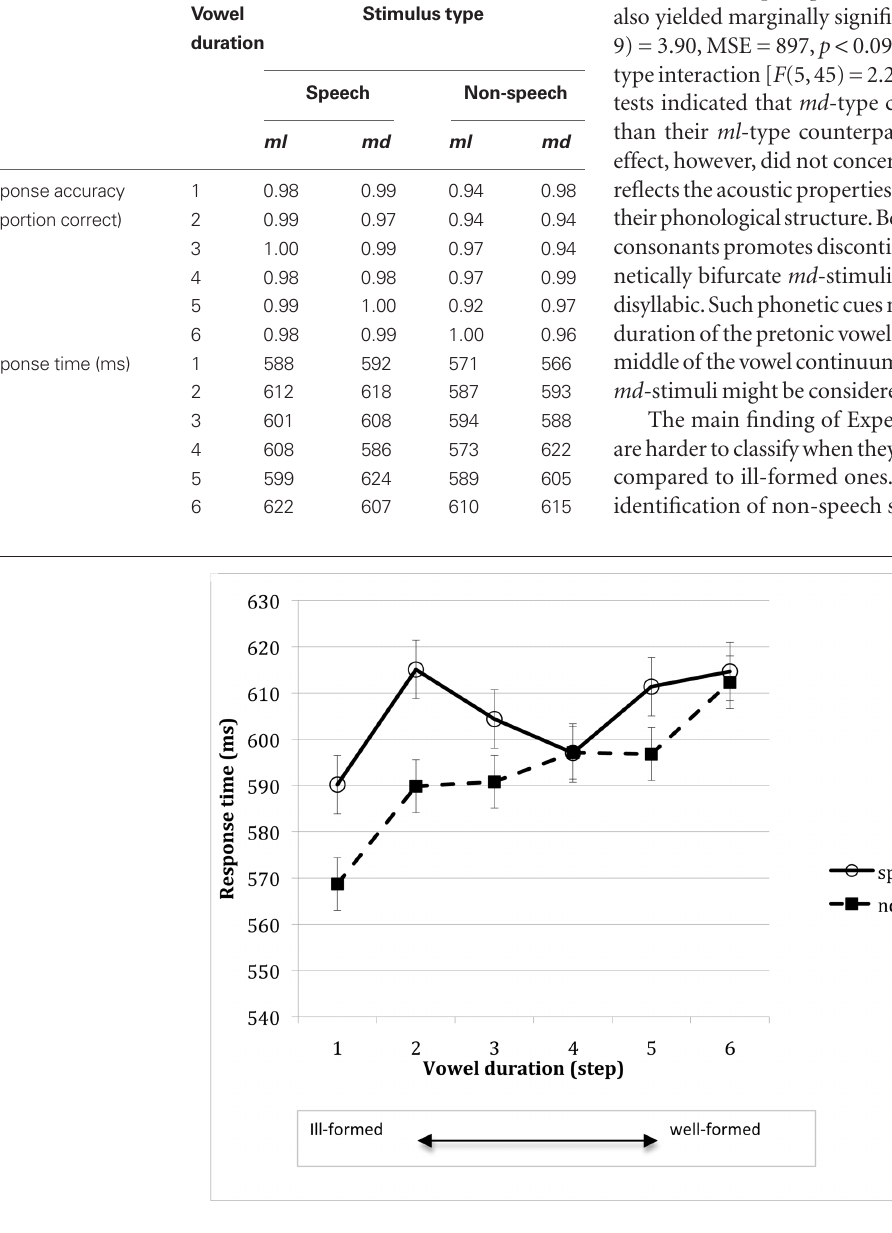
Figure 2 | response time to speech and non-speech stimuli as a function of vowel duration (in experiment 1). Error bars reflect confidence intervals, constructed for the difference among means along each of the vowel duration continua (i.e., speech